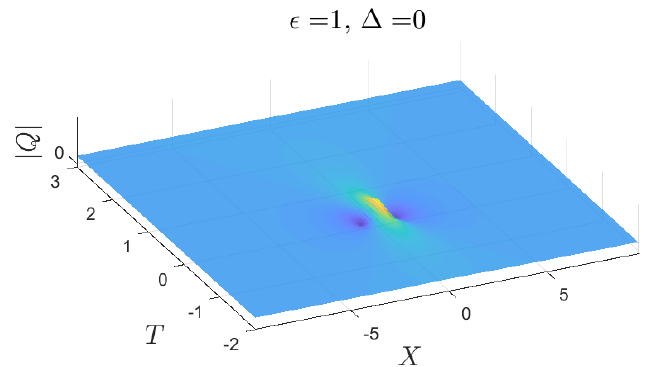
Figure 1. Case 1: Surface plot of the unforced Peregrine breather (10) when (cid:101) = 1.0, M = 1, ∆ = 0.0.